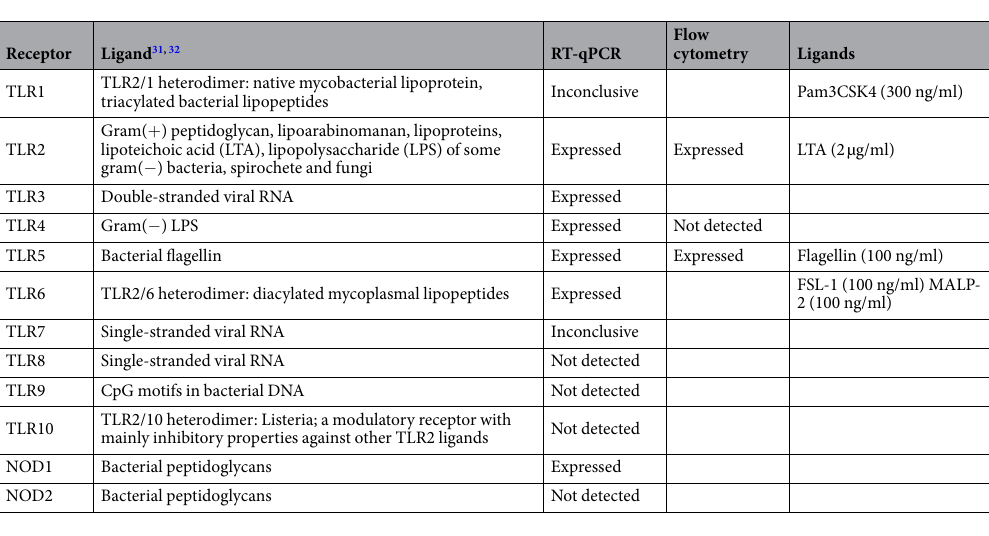
Table 1. Toll-like receptors in gingival epithelial